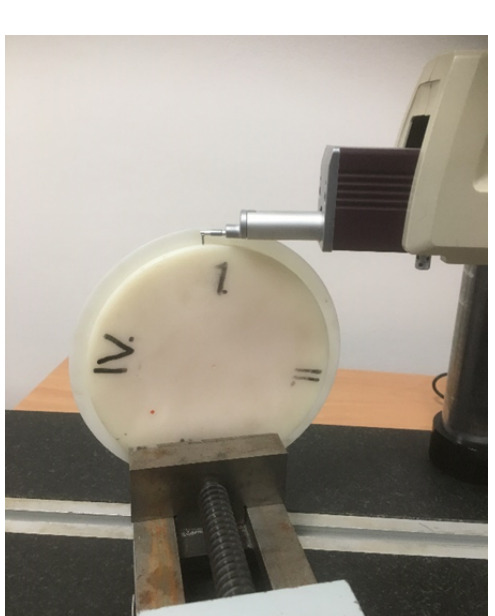
Figure 13: The measurement of roughness in the four quadrants performed on the measuring device Mitutoyo SJ